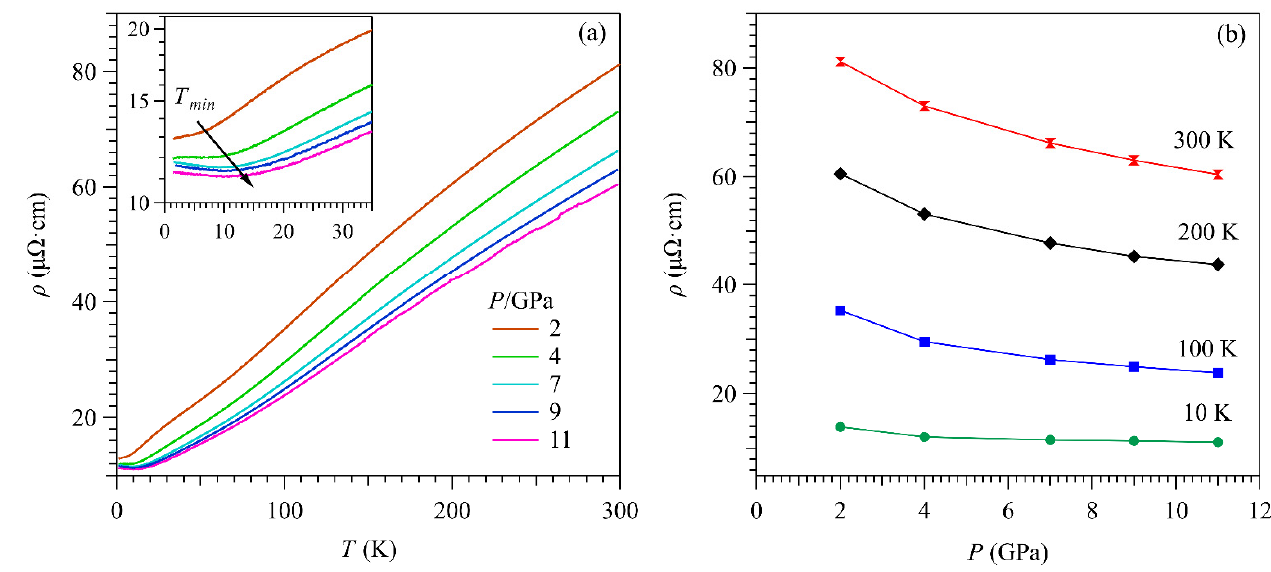
Figure 4. ( a ) Temperature dependence of resistivity for ScV 6 Sn 6 measured in the cubic anvil cell under various pressures up to 11 GPa. Inset shows the low-temperature data from 1.5 to 35 K. ( b ) Pressure dependence of resistivity at 300, 200, 100, and 10 K.